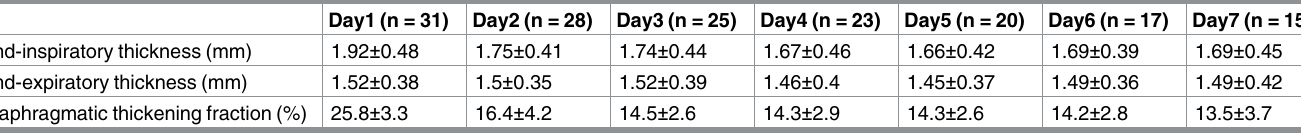
Table 2. Averageof daily ultrasound measurements over time in the first week of MV.